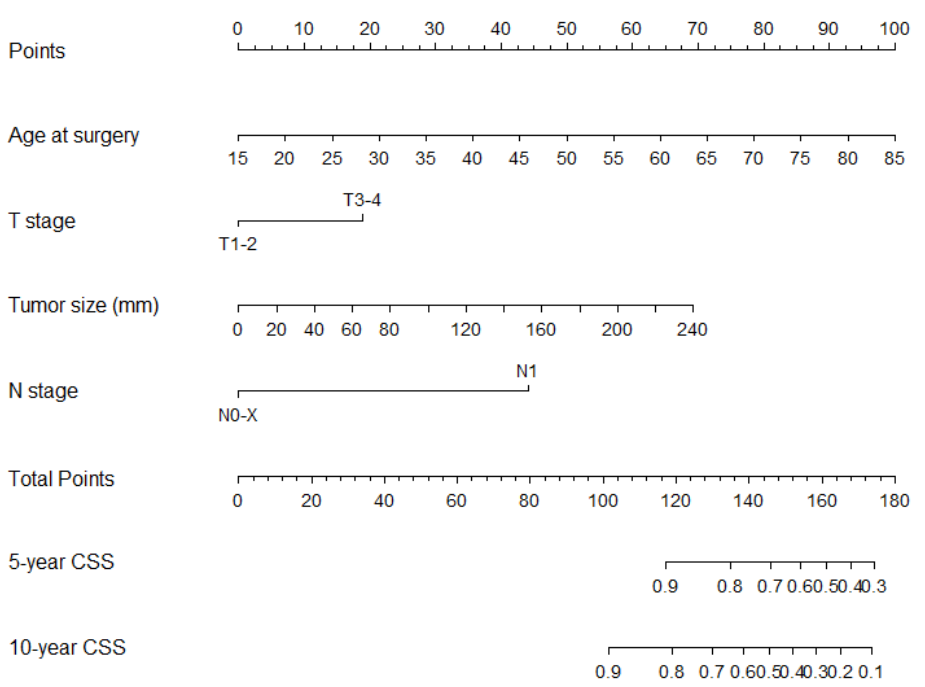
Figure 2. Nomogram predicting cancer-specific survival in surgically treated non-metastatic chromo- phobe renal cell carcinoma at five and ten years after surgery. Table 3. Univariable and multivariable Cox regression models predicting cancer - specific mortality.